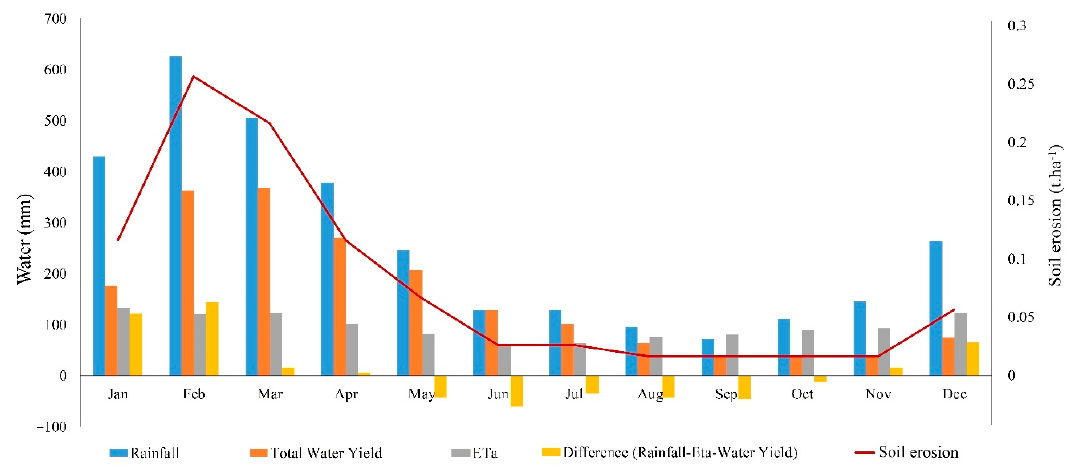
Figure 7. Average monthly rainfall, total water yield, actual evapotranspiration and sediment yield at catchment scale for 22 years simulation period (1991–2012) and 500 simulations. The simulated average annual soil erosion rate of the North Johnstone catchment ranges from 0.7 to 2.13 t · ha –1 . The average monthly water balance and soil erosion rate show a close correlation